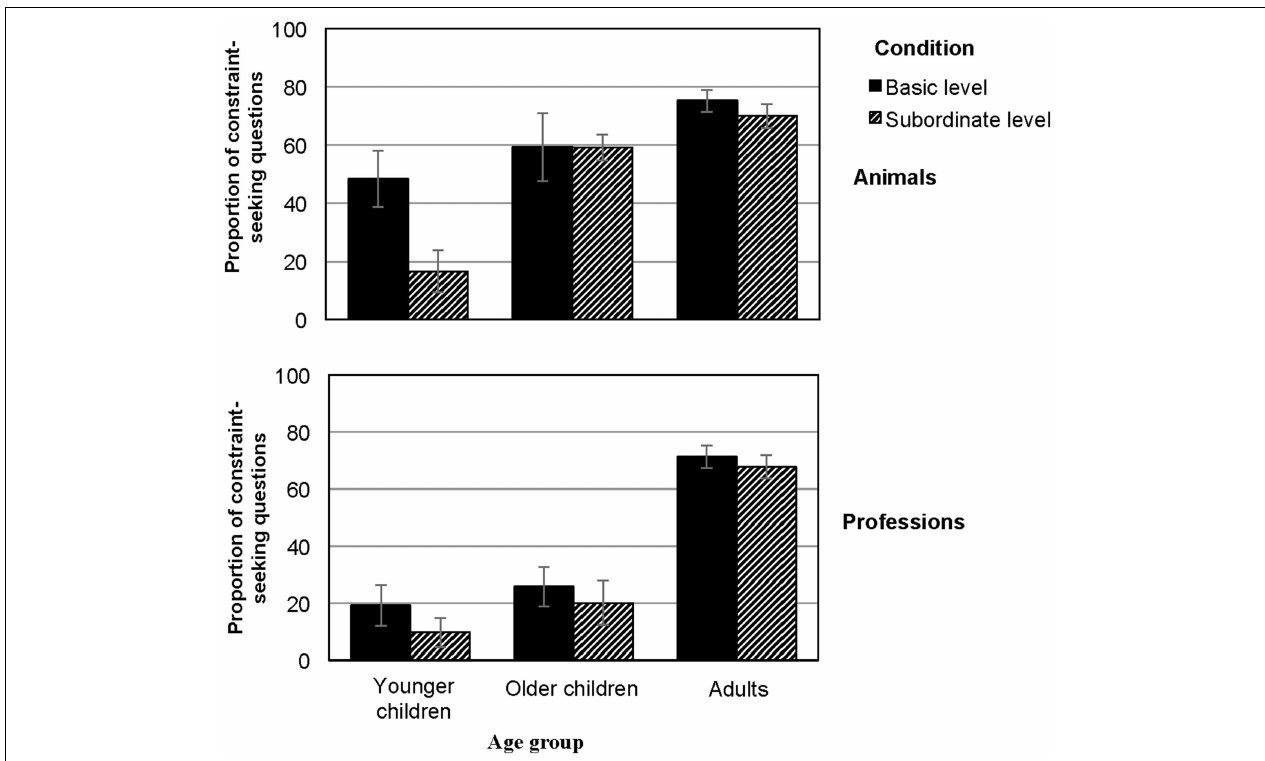
FIGURE 3 | Percentage of participants’ constraint-seeking questions, displayed by domain (animals, professions) and condition (basic level, subordinate level).